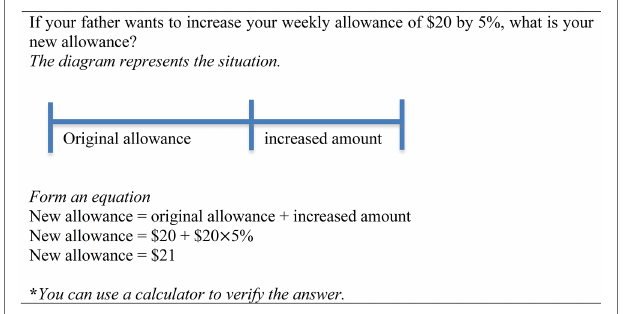
FIGURE 3 | A worked example of the percentage change problem. Source: Ngu et al.